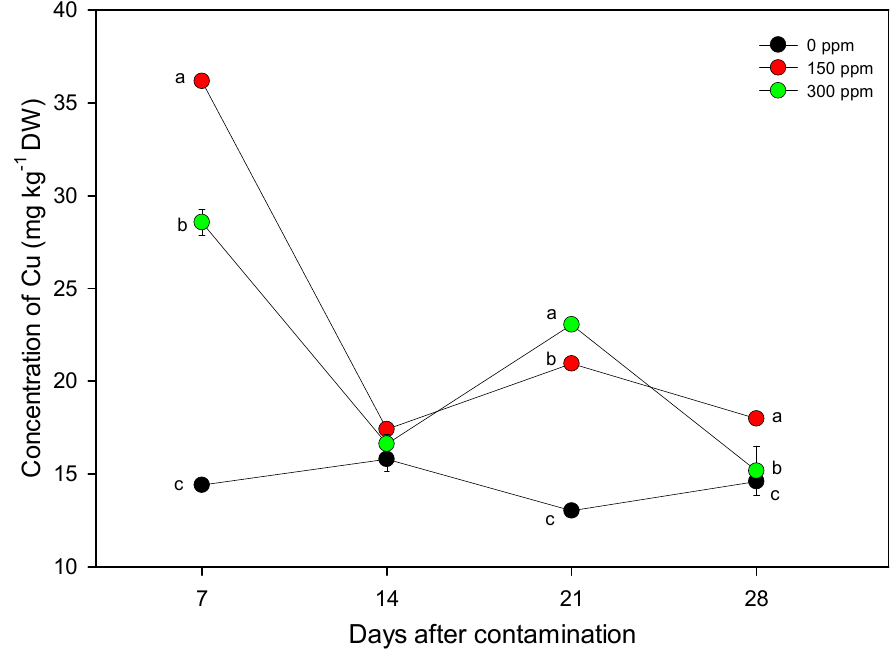
Figure 6. Time course of the copper concentration in the leaves of Arundo plants treated with different copper concentrations (0, 150, and 300 ppm) for 28 days. Data points and vertical bars represent means (n = 3) ± S.E., respectively (when not reported S.E. is smaller than symbol size). One-way ANOVA was applied and for a given duration different letters indicate significant difference according to Tukey test ( p ≤ 0.01).